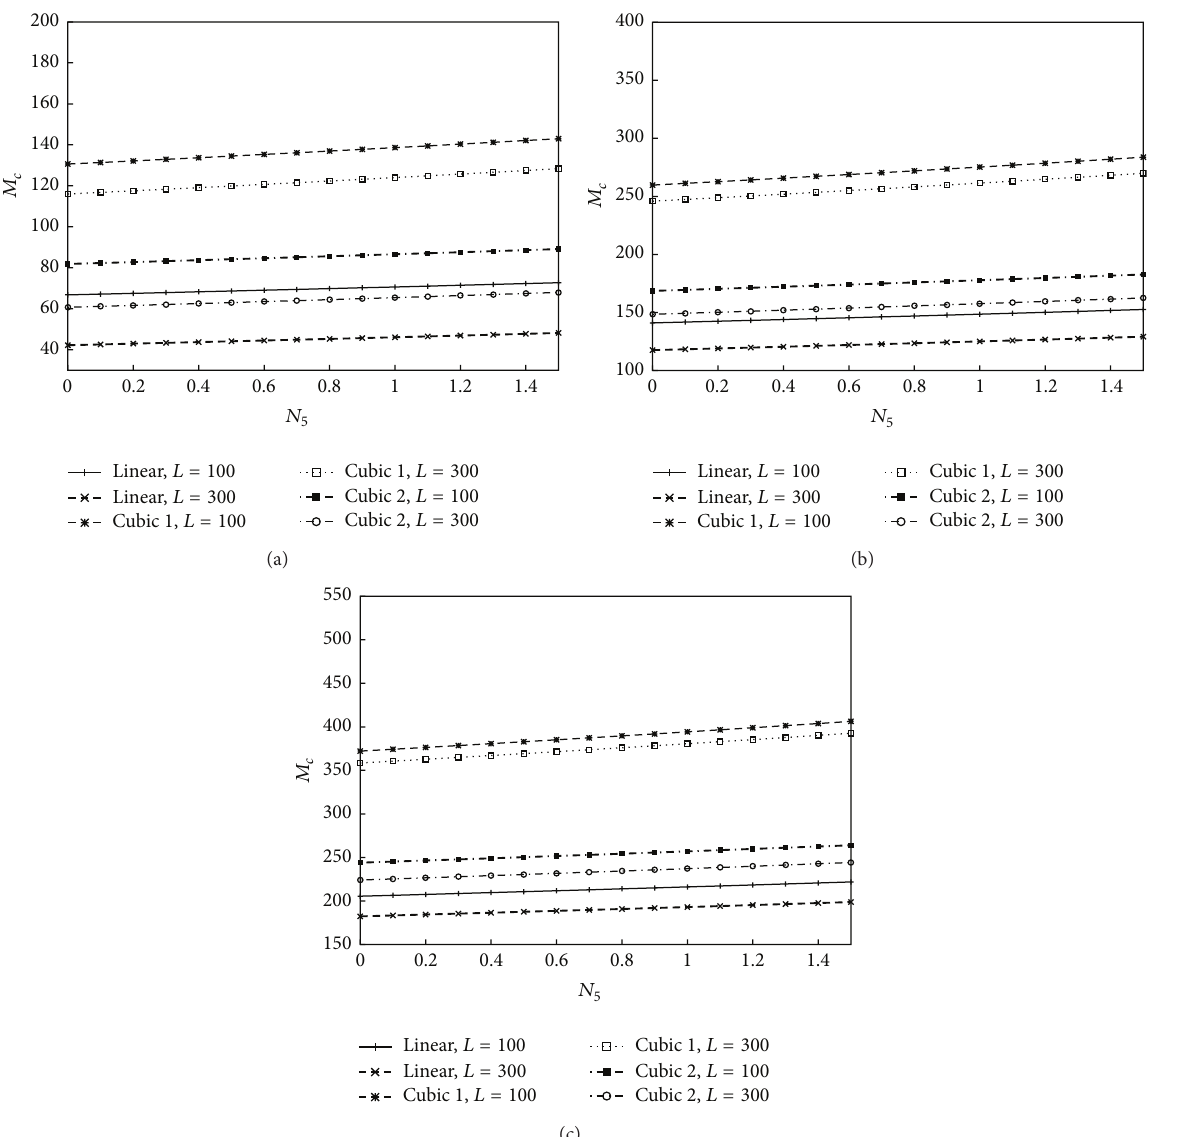
Figure 4: Plot of critical Marangoni number, 𝑀 𝑐 , versus micropolar heat conduction parameter, 𝑁 5 , for different electric number, 𝐿 , and (a) 𝐾 = 0 , (b) 𝐾 = 4 , and (c) 𝐾 = 8 .